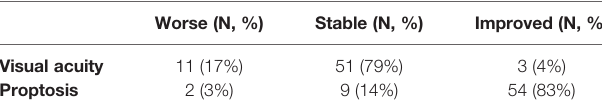
TABLE 4 | Visual acuity and proptosis after surgery at last examination. Worse (N, %) Stable (N, %) Improved (N,